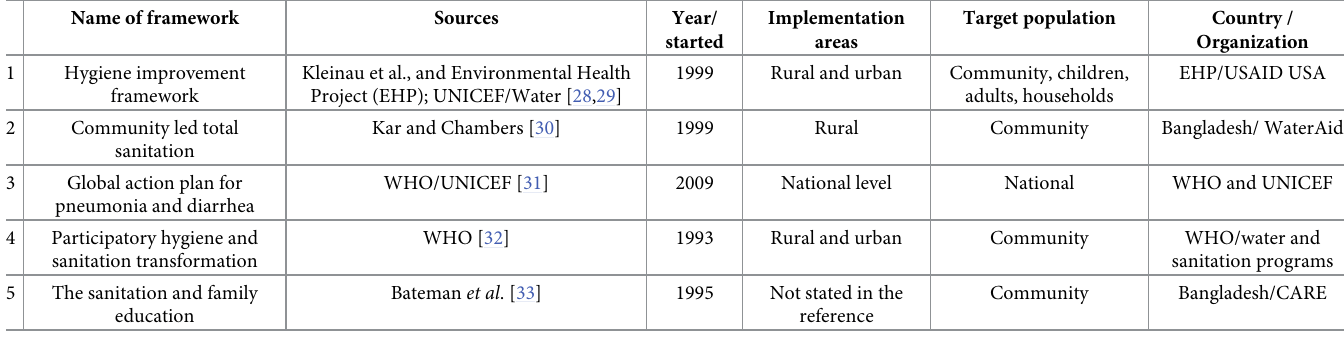
Table 2. Characteristics of frameworks aimed at mitigating waterborne diarrheal diseases included in the scoping review. Name of framework